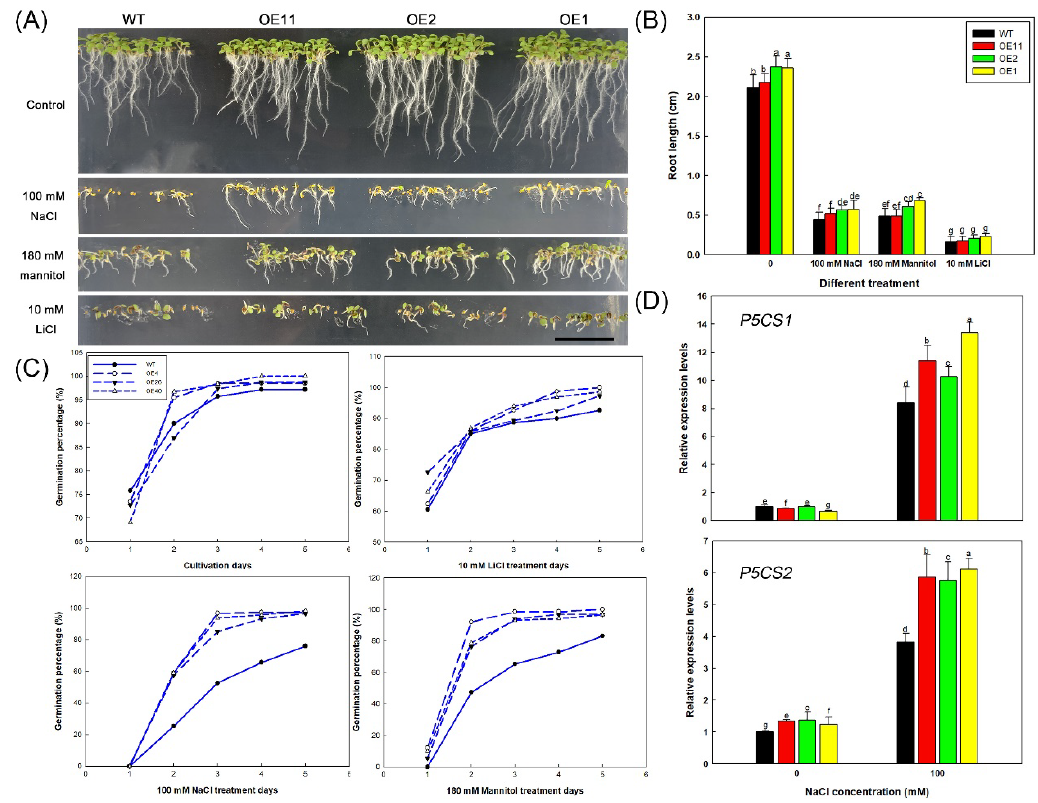
Figure 7. Lb1G04202 enhances salt tolerance by alleviating osmotic stress in Arabidopsis. ( A ) Col-35S:: Lb1G04202 seeds grown on medium containing 100 mM NaCl, 10 mM LiCl, and 180 mM mannitol for 5 d. Bar = 1 cm. ( B ) Root lengths of 5-d-old seedlings determined using ImageJ software. Thirty seedlings were analyzed per line. Data are the mean ± SD of 30 plants. ( C ) Germination percentage calculated each day after sowing on different media. Forty seeds per line were sown per treatment, and three replicates were performed. Data are the mean ± SD of 40 plants; different letters indicate significant differences at p = 0.05 according to Duncan’s multiple range test. ( D ) Relative expression levels of AtP5CS1 and AtP5CS2 in Arabidopsis Col-35S:: Lb1G04202 lines. The expression level of each gene was measured by qRT-PCR with three biological replicates (separate experiments); different letters indicate significant differences at p = 0.05 according to Duncan’s multiple range test.